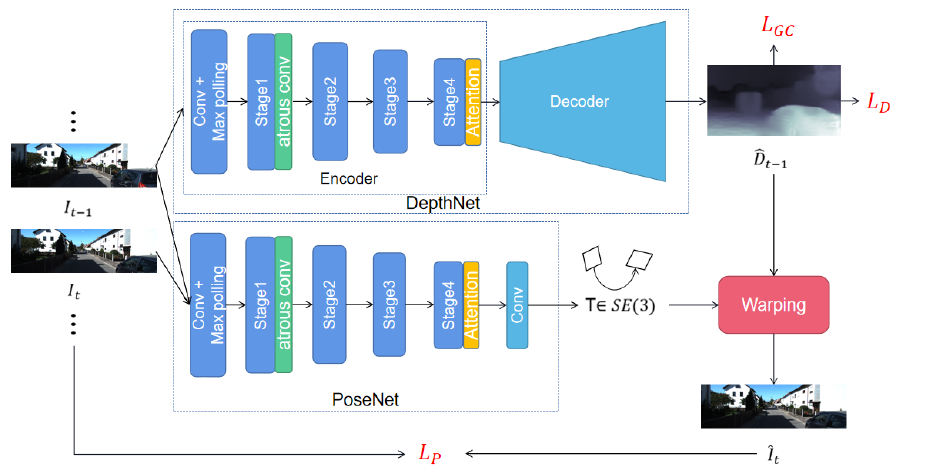
Figure 1. Illustration of our proposed framework. The DepthNet takes a single image as input and predicts corresponding depth map ˆ D t − 1 . The PoseNet takes every two consecutive images as input and predicts corresponding camera pose T t − 1, t . The differentiable image warping is applied to reconstructed image ˆ I t , then we calculate the photometric consistency loss L P according to I t and ˆ I ˆ D t . The depth map t − 1 is used to calculate the depth loss L D and geometry consistency loss L GC . Atrous conv denotes the densely linked atrous convolution layers, and attention denotes the non-local self-attention